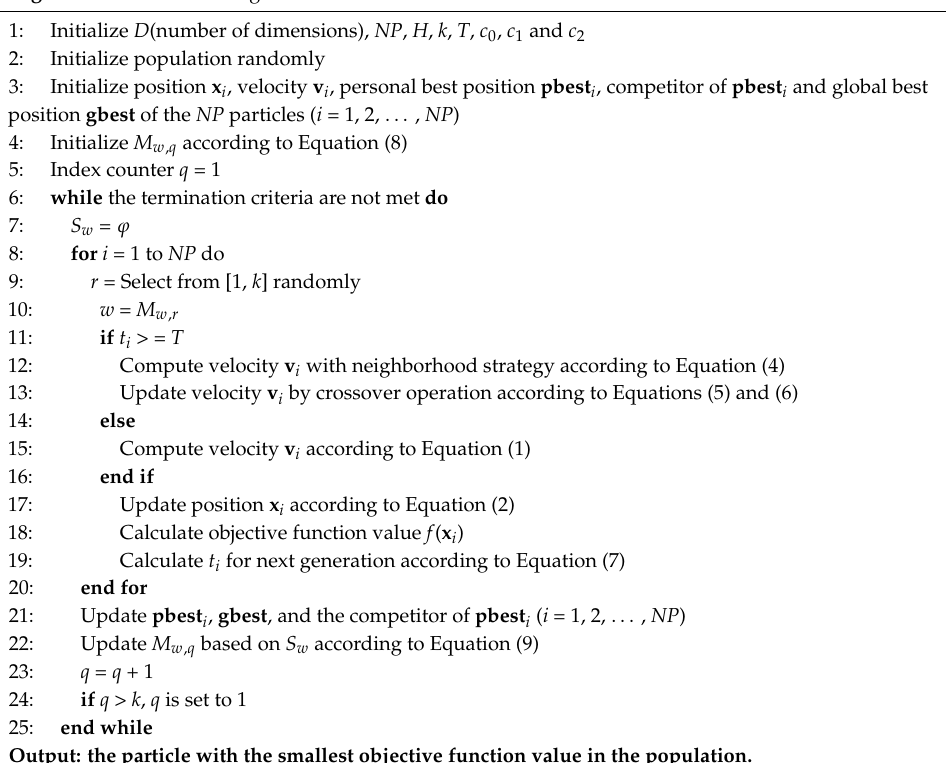
Algorithm 1. PSONHM